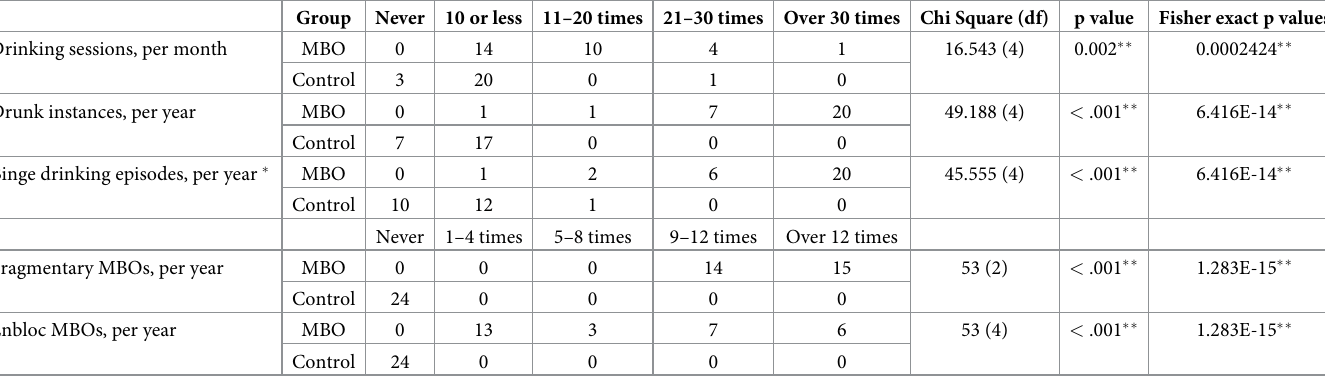
Table 1. Self-reported frequency of drinking behaviours between MBO (n = 29) and Control (n = 24) groups.